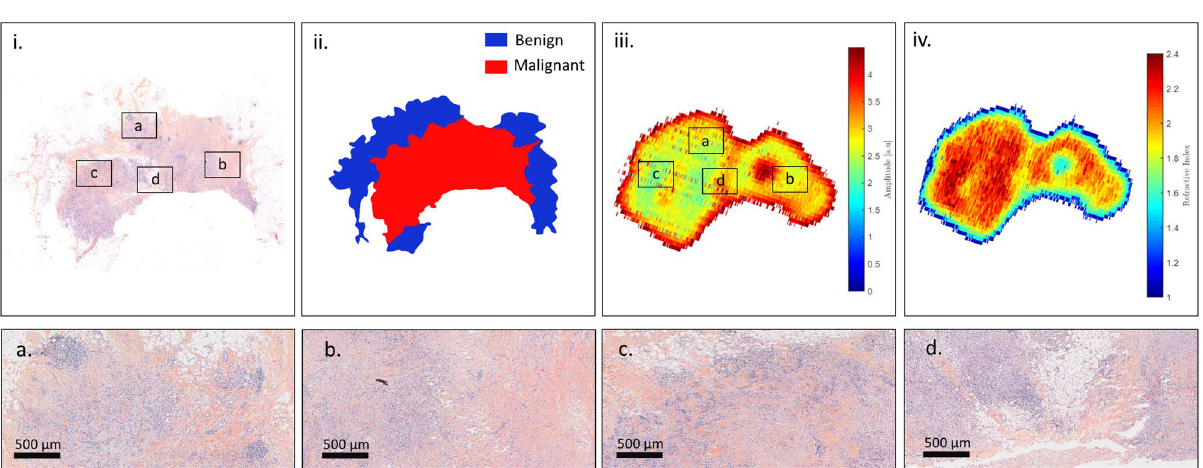
Figure 12. TS#2 tissue sample classification maps at 550-GHz for (cid:31) two best thresholds. “Not applicable” refers to regions where the binary pathology classification and the binary terahertz classification image do not match spatially. The values listed in each box are respectively standing for the refractive index threshold, the true positive rate and the false positive rate.